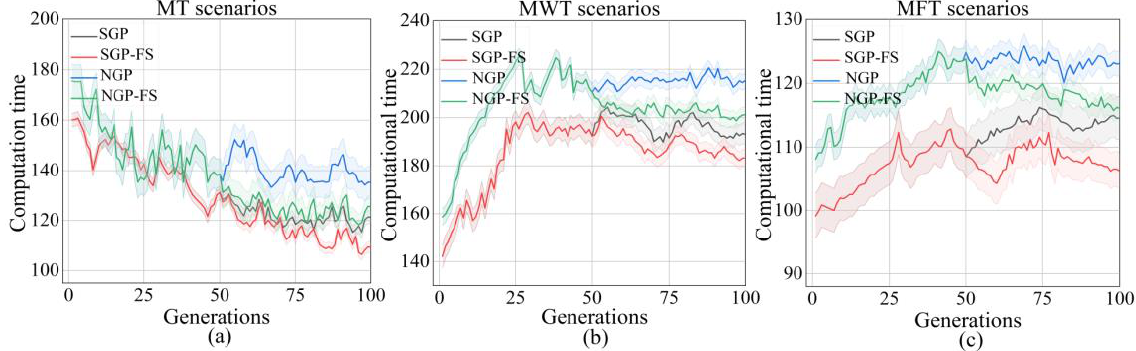
Figure 5. The computational time of the GP algorithms for the three objectives in the training stage. (a): Computational time across generations for the MT scenarios, (b): Computational time across stage. ( a ): Computational time across generations for the MT scenarios, ( b ): Computational time generations for the MWT scenarios, and (c): Computational time across generations for the MFT across generations for the MWT scenarios, and ( c ): Computational time across generations for the scenarios. MFT